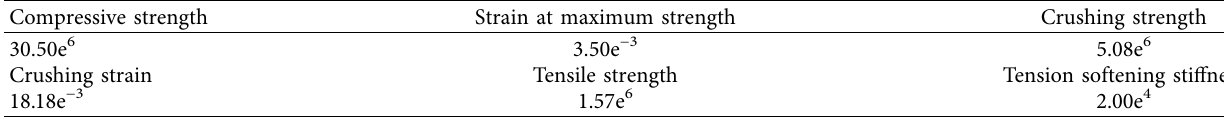
Table 6: Parameter values of unconfined concrete used in FE modelling.